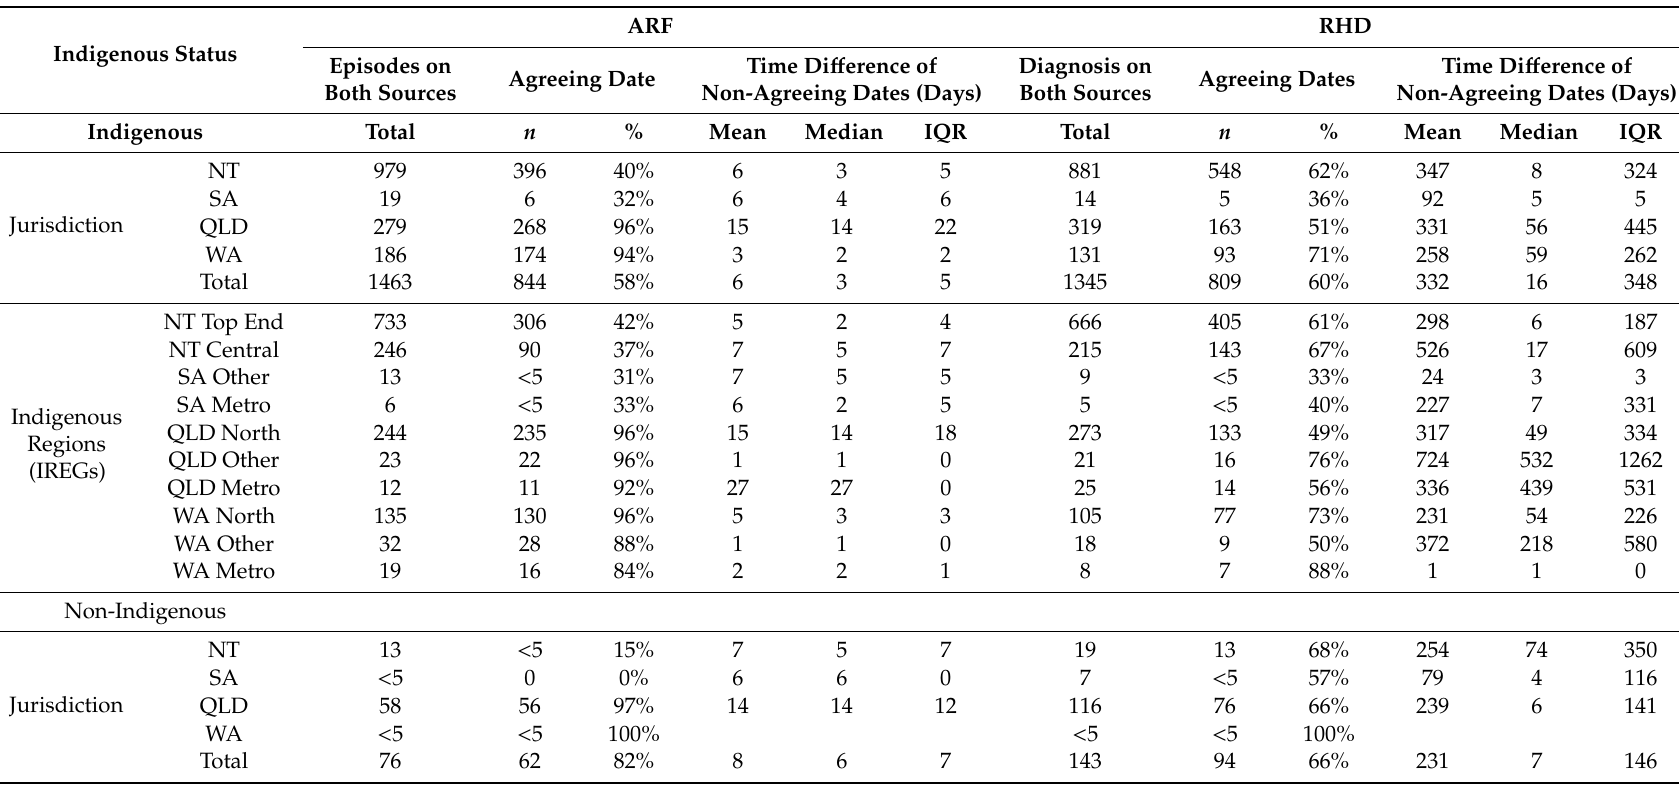
Non-Agreeing Dates (Days)